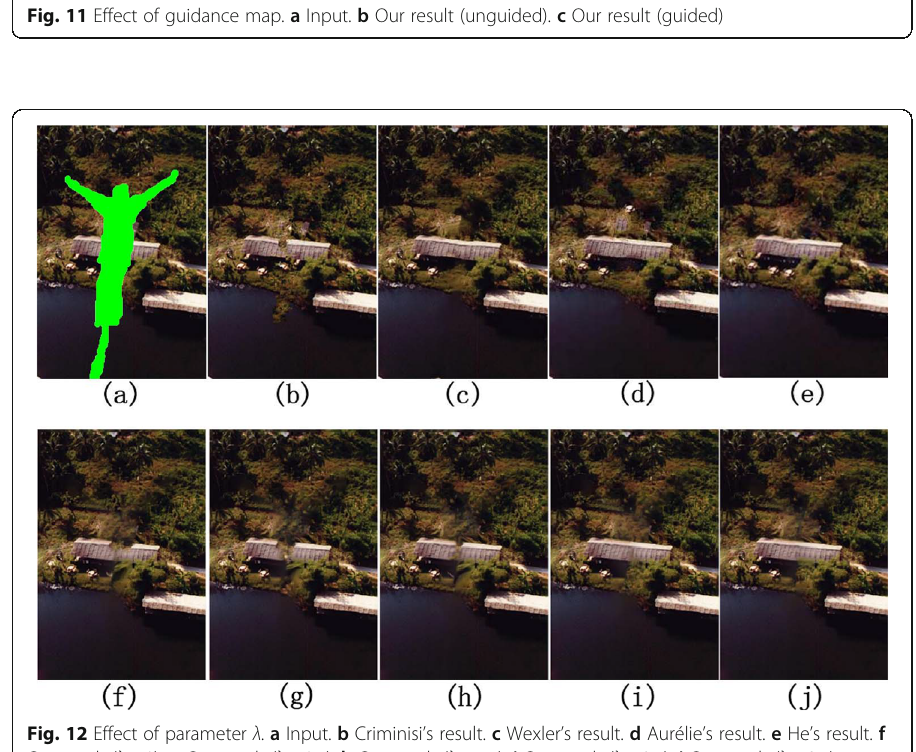
Fig. 12 Effect of parameter λ . a Input. b Criminisi ’ s result. c Wexler ’ s result. d Aurélie ’ s result. e He ’ s result. f Our result ( λ = 0). g Our result ( λ = 0.5). h Our result ( λ = 1.5). i Our result ( λ = 2.5). j Our result ( λ = 3.5)